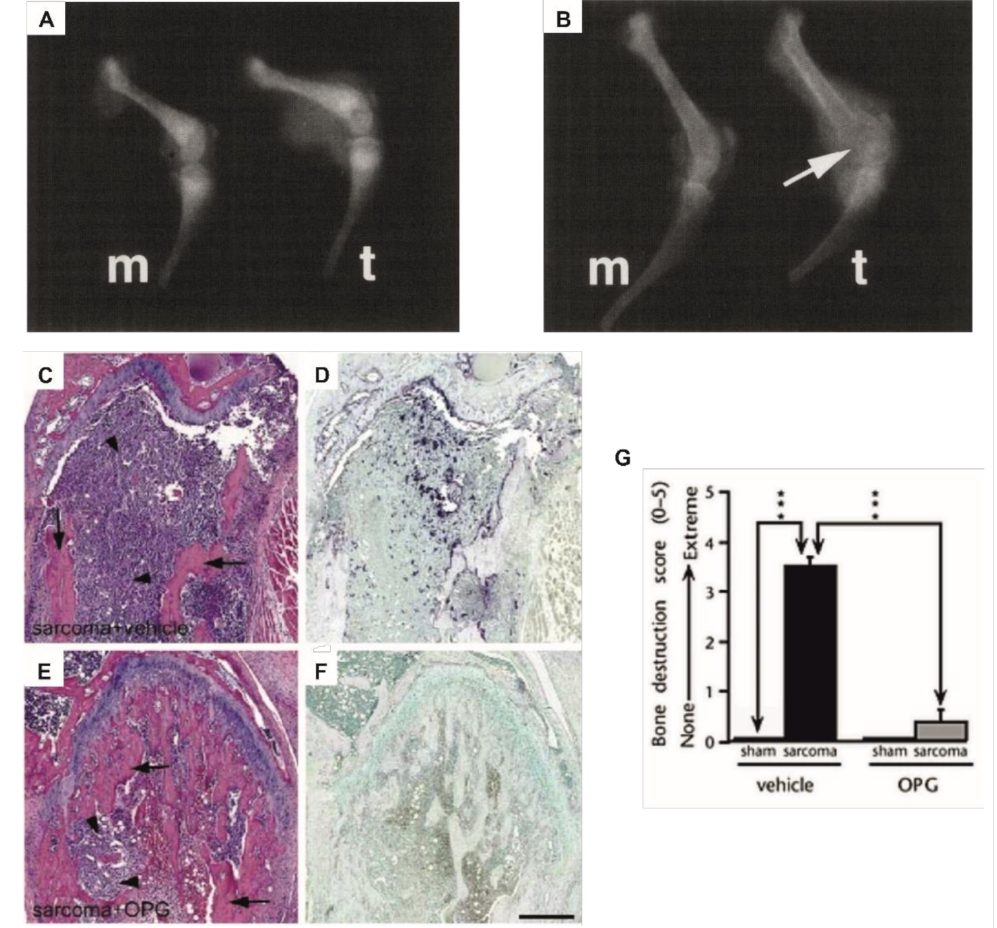
Figure 1. Examples of a central role of osteoclasts in primary bone cancer-induced osteolysis. ( A , B ) X-ray images of femurs from ( A ) osteoclast-deficient strain B6C3Fe-a/a-Mitf mi or ( B ) wild type mice, 14 days after inoculation with medium alone (m) or osteolytic sarcoma cells (t). Osteolysis (arrow) was only observed in the wild type mice. ( C – F ) Sections of sarcoma-inoculated mouse femurs stained with hematoxylin and eosin ( C , E ) or tartrate-resistant acid phosphatase, staining osteoclasts dark violet ( D , F ). Arrows indicate bone and arrow heads indicate tumor cells. OPG treated mice ( E , F ) showed greatly reduced bone destruction and diminished osteoclast numbers compared to vehicle treated mice ( C , D ). ( G ) Bone destruction score in sham and sarcoma inoculated mice from the same experiment as C – F , treated with OPG or vehicle. Data are shown as mean ( ± s.e.m.). *** p < 0.001, one-way ANOVA, Fisher PLDS, arrows indicate the groups being compared. ( A , B ) Reproduced with kind permission from Clohisy and Ramnaraine, Journal of Orthopaedic Research; published by John Wiley and Sons, 1998 [63]. ( C – G ) Reproduced with kind permission from Honore et al., Nature Medicine; published by Springer Nature, 2000